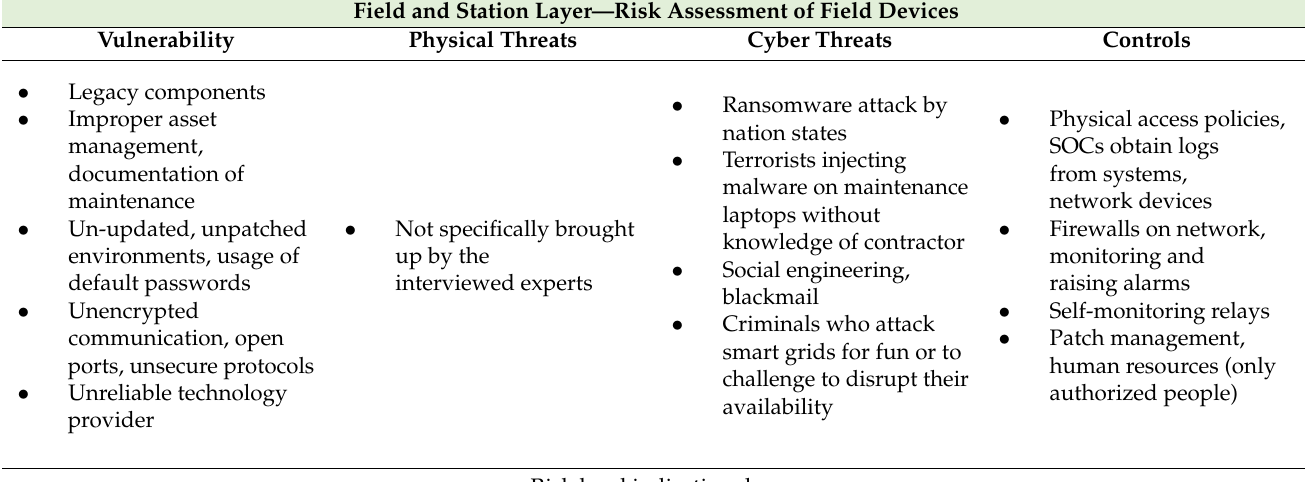
Table 7. Risk assessment of field